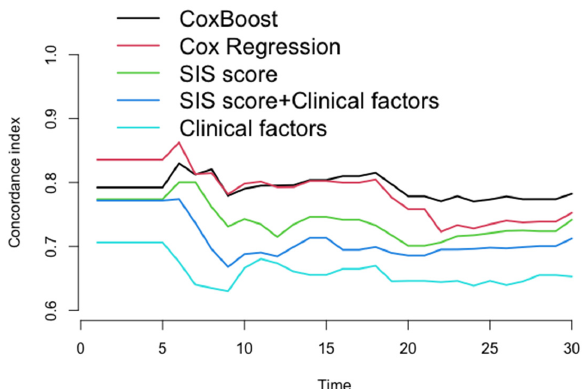
Figure 4. The concordance index for each model in testing dataset every month. After 22nd month in follow-up, compared to other models (Cox regression, SIS score, SIS score + clinical factors, and clinical factors), the C-index of ML model for prediction of the MACE in the testing dataset was significantly increased (C-index: 0.770–0.782, 0.723–0.752, 0.706–0.742, 0.786–0.712, 0.639–0.653, p < 0.05). Table 3. The performance (concordance-index) for each model validated at each half year of follow- up.